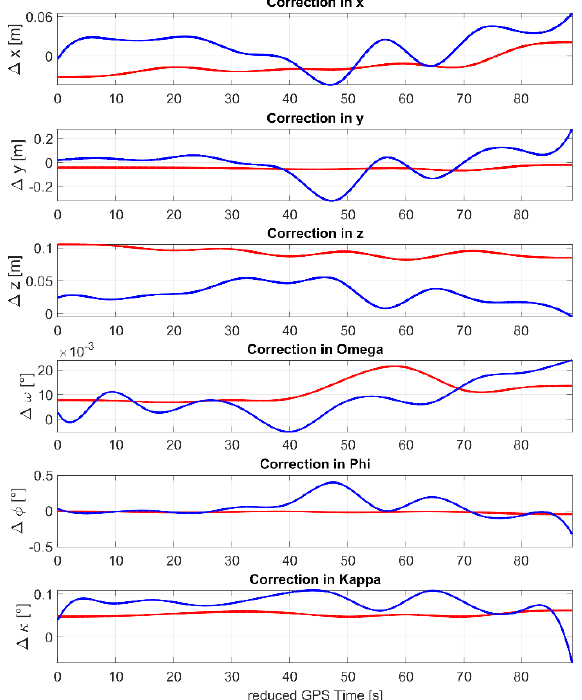
Figure 4. Comparison of adjusted trajectory for one exemplary longitudinal strip when using spline trajectory correction by LiDAR strip adjustment (blue) and hybrid orientation (red). (GPS time reduced to first measurement).